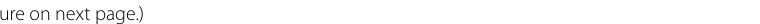
figure on next Fig. 7 Conceptual block diagrams and Schmidt (equal area) plots (maximum K max , intermediate K int and minimum K min axes represented by squares, triangles and circles, respectively; projection on the lower hemisphere showing different relationships between crystal orientation, magma flow direction, and principal susceptibilities). The blocks represent a section of a north–south vertical dike with vertical upward magma flow direction. The equal area plots are from the eastern dike margins. For realism, it is considered that the crystal orientations show some, but limited, scattering around a mean direction. a “Normal” fabric K max on the Schmidt plot corresponds to the magnetic zone axis. b “Inverse” fabric related to the presence of SD grains. c Rolling effect of large grains with K max oriented normal to flow direction (within the plane of the dike, K int and K min are parallel to flow direction according to the Fig. 6). Original diagrams are from Cañón‑Tapia